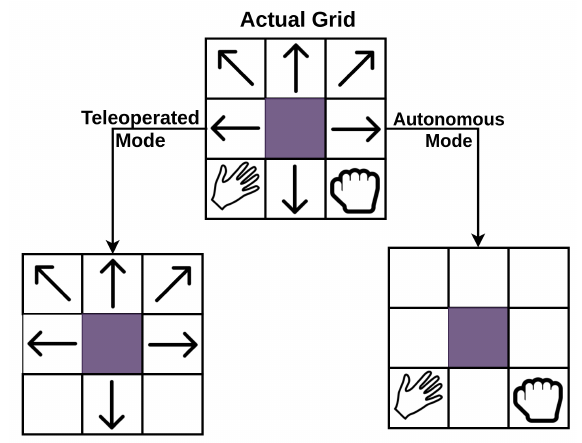
Figure 6. 3 × 3 matrix showing user interface (adapted from: [66]). ( left ) Teleoperated Mode: User gives directional command using only arrows and ( right ) Autonomous Mode: User gives high-level commands corresponding to the symbol.